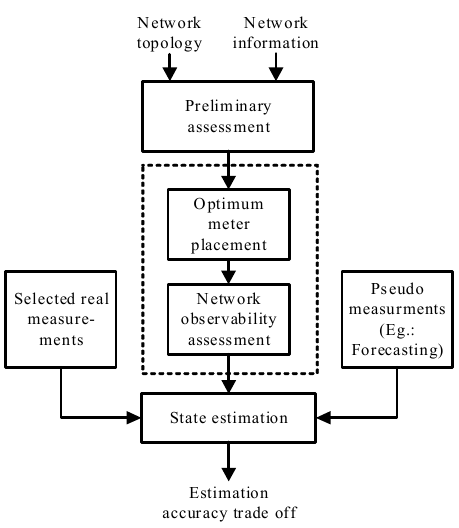
Figure 1. Working flow diagram of the proposed model.